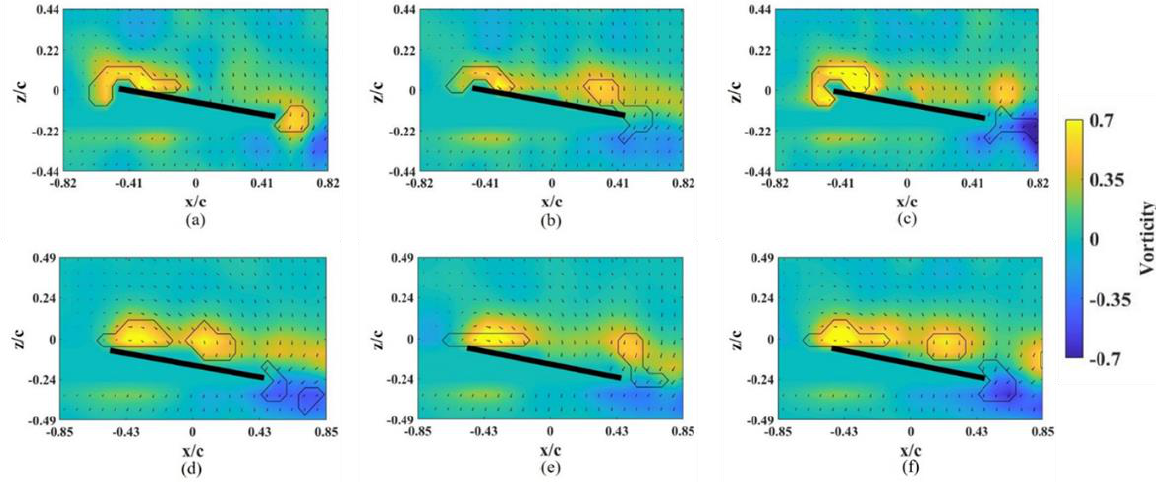
Figure 3. Vorticity contours around the base wing model without alula-VG on different x-z planes at α = 10°. ( a ) r * = 0.36, ( b ) r * = 0.46, ( c ) r * = 0.56, ( d ) r * = 0.66, ( e ) r * = 0.76, and ( f ) r * = 0.8.